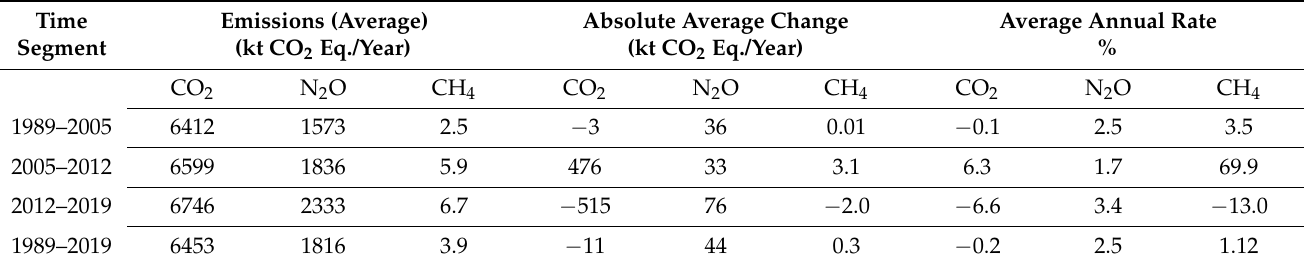
Table 5. Comparative synthetic indicators of the evolution of GHG